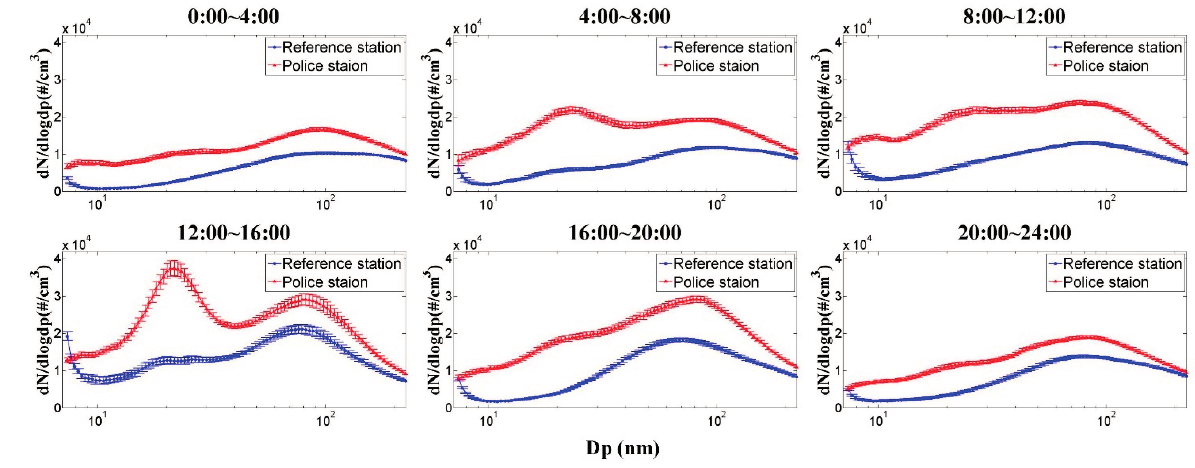
Figure 4. Average size distribution and number concentration from SMPS data for different four-hour working shifts at the police station and reference station. The error bar represents one standard